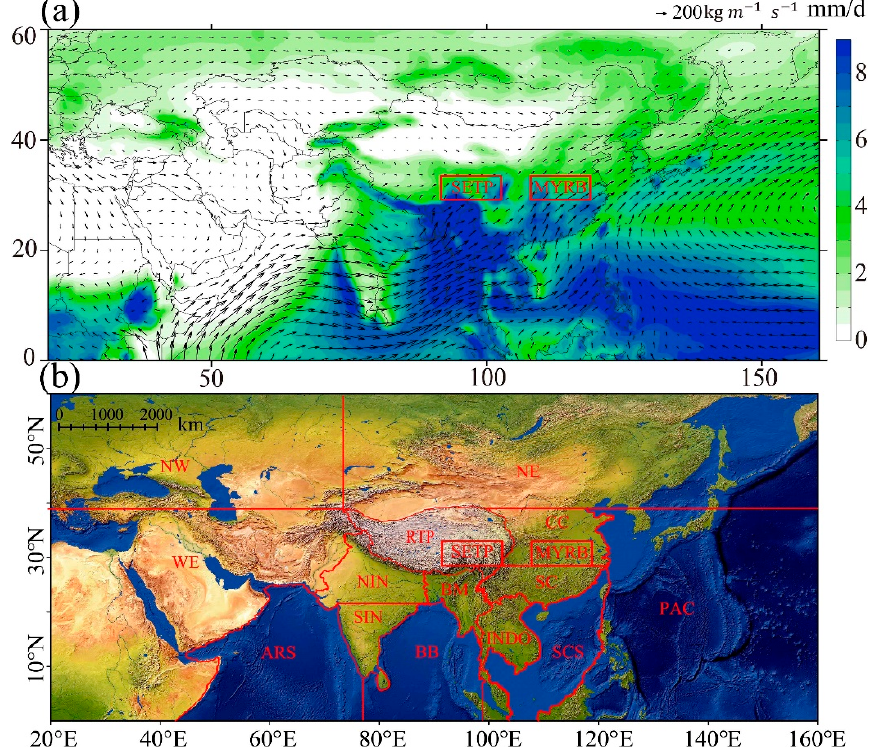
Figure 1. ( a ) Annual mean precipitation (shades) and column integrated moisture flux from surface to 50 hPa (arrows) in the wet season (April–September) in the study region, over 1982–2011. ( b ) Sixteen sub-regions of the evaporative source of precipitation in the two target regions. The Southeast Tibetan Plateau (SETP) and the Middle Yangtze River Basin (MYRB) are the two target regions, indicated with red rectangles. In addition to the two target regions, 14 sub-regions in Figure 1b include the rest of the Tibetan Plateau except for the SETP (RTP), the Bay of Bengal (BB), Northern India (NIN), Southern India (SIN), Central China (CC), Bangladesh and Myanmar (BM), the Arabian Sea (ARS), Southern China (SC), the South China Sea (SCS), Indochina (INDO), the Pacific Ocean (PAC), the western area (WE), the northwestern area (NW) and the northeastern area (NE).